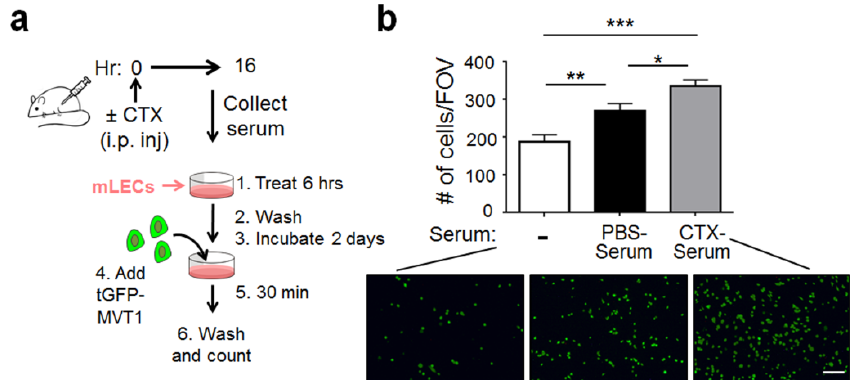
Figure 3. CTX-serum increased the mLEC adhesiveness in vitro. ( a ) A schematic. ( b ) Top : Quantifi- cation of tGFP-MVT1 cells per FOV adhered to mLECs pre-treated with CTX-serum, PBS-serum, or medium only (−) ( n = 13–14 from 3 independent experiments). Total 360 images from 3 groups were pooled, randomized and scored in blind. Bottom : Representative images. Scale bar, 100 μm. Bars indicate mean ± SEM; one-way ANOVA with post hoc Holm–Šídák correction; * p < 0.05; ** p < 0.01; *** p < 0.001.